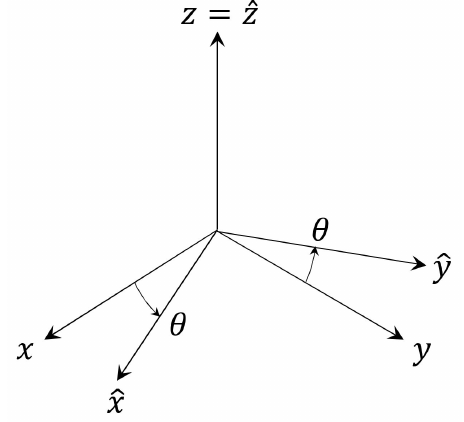
Figure 13. ˆ x ˆ y ˆ z coordinate system for the incident angle θ